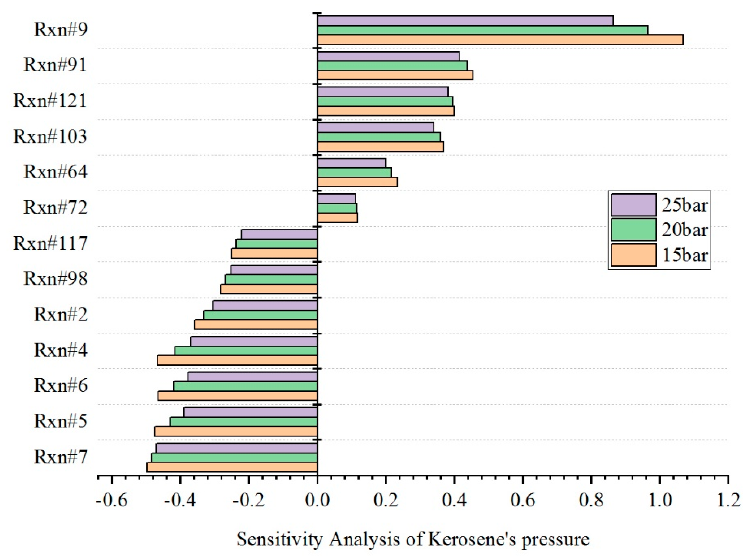
Figure 9. Sensitivity analysis of kerosene under different initial pressures.